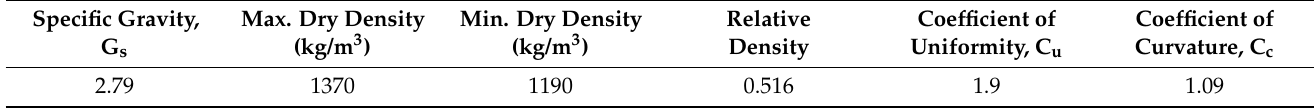
Table 1. Properties of sand sample.